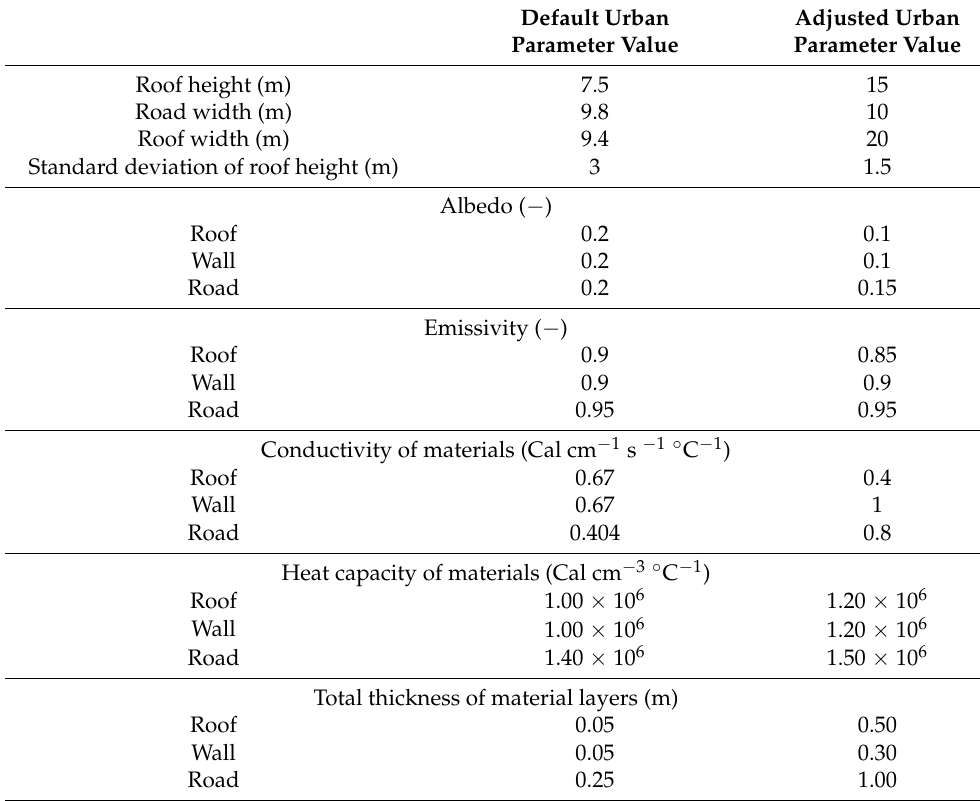
Table 2. Default and adjusted urban parameter values that are assigned to the urban